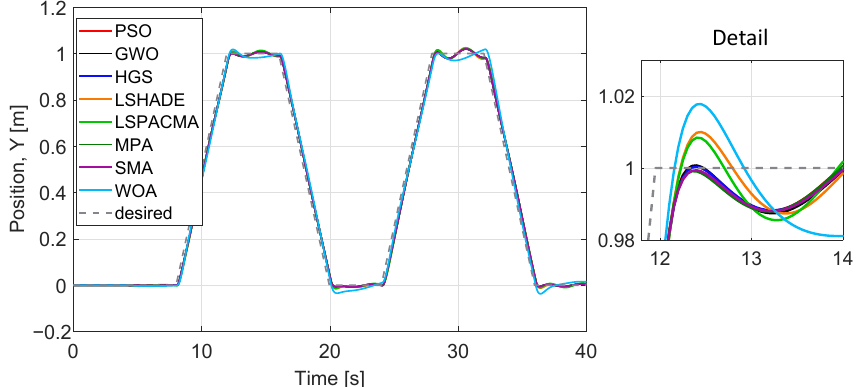
Figure 7. Comparison of tracking performance in Y–axis of the different algorithms evaluating parameters obtained with 20 individuals.